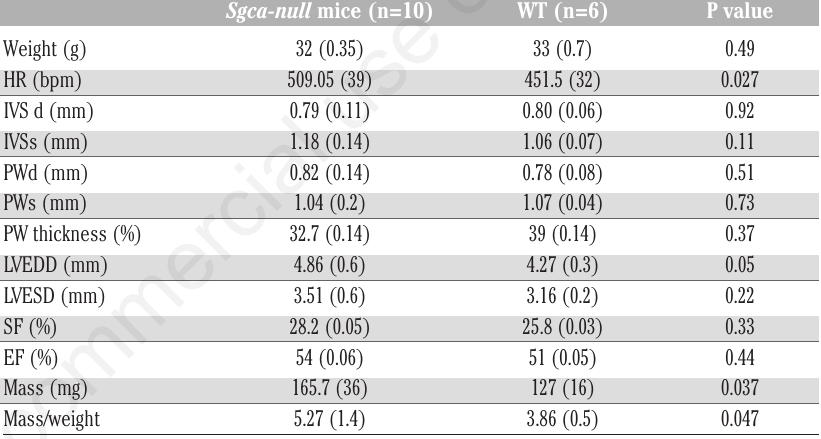
Table 2. Comparison of WT mice and sgca-null mice echocardiographic’s parameters at 15 months of age.